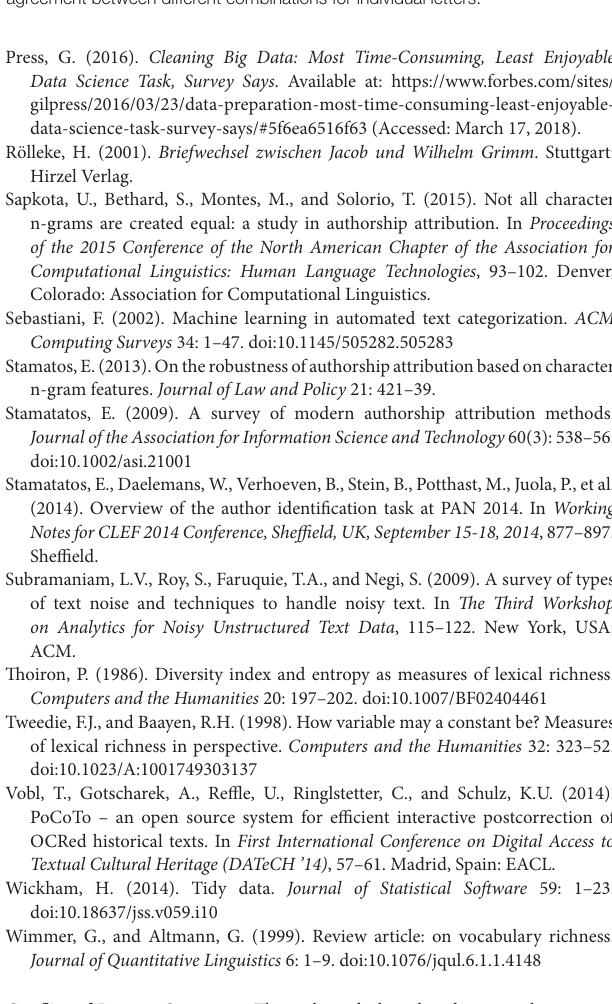
Table s1 | Overview of the prediction for the three intra-modality models. Table s2 | Outcome of the cross-modality experiments, showing the agreement between different combinations for individual